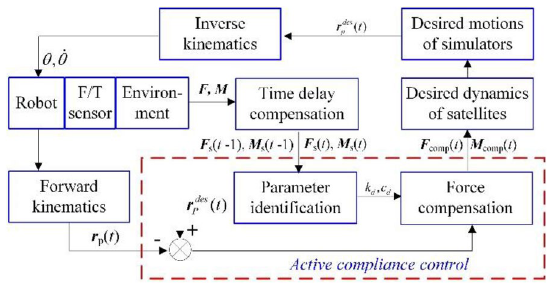
Figure 5 Active compliance control